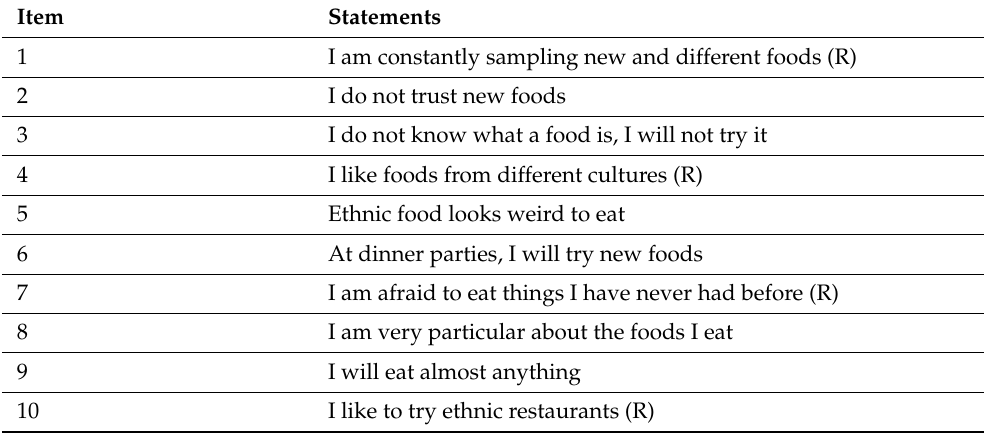
Table 4. Items of the food neophobia